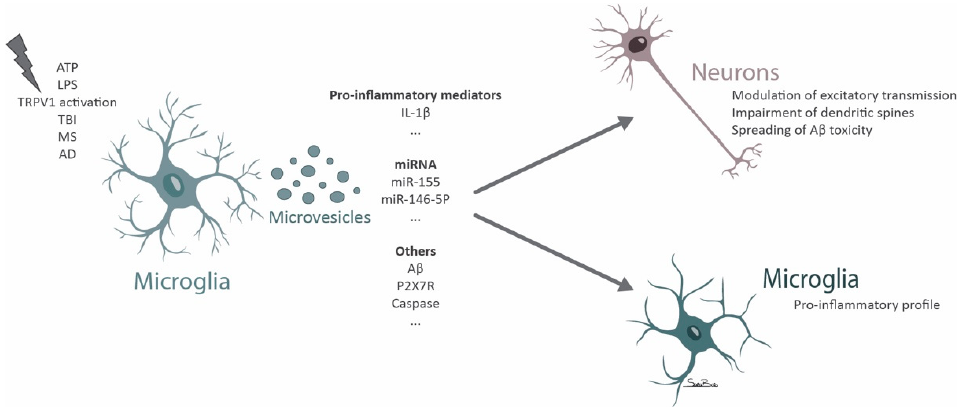
Figure 2. Scheme summarizing the role of microglial microvesicles in neurodegeneration. Microglia isolated from TBI mice were shown to release microvesicles that can induce microglia reactivity in vitro [142]. When microglial cells in culture are exposed to lipopolysaccharide (LPS) the release of microvesicles enriched in IL-1 β and miR-155 increases